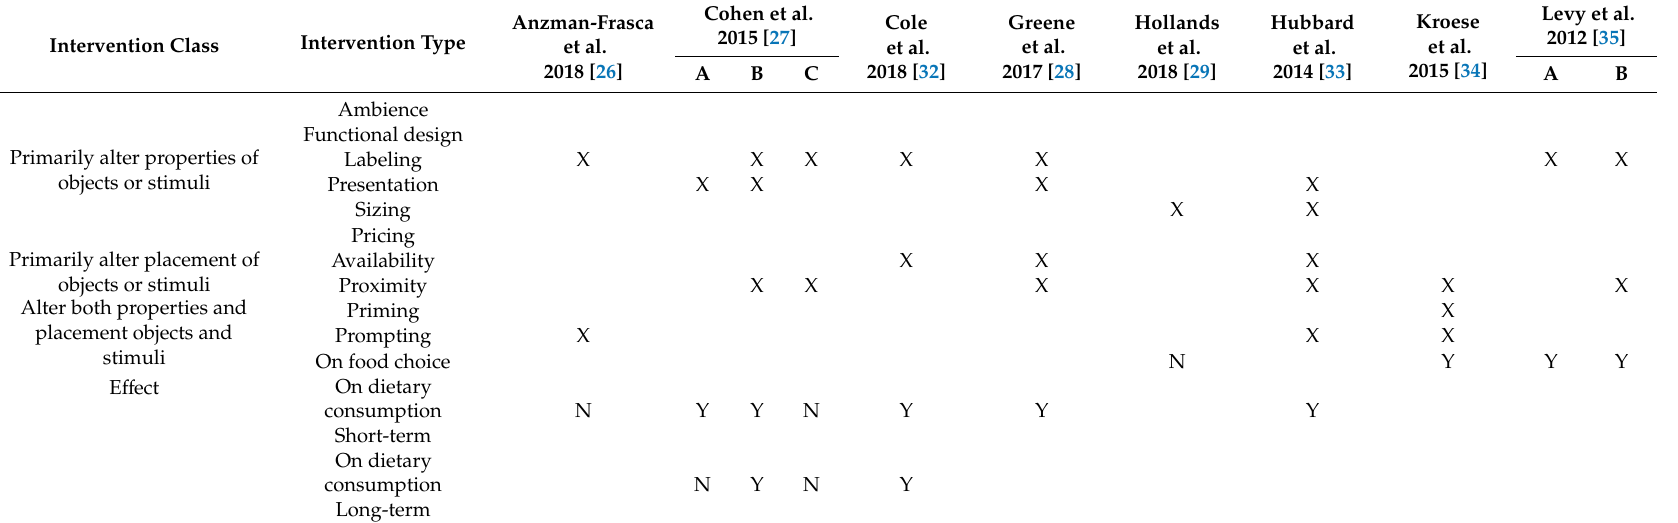
Table 4. Nudging and choice architecture types and e ff ectiveness examined in the included